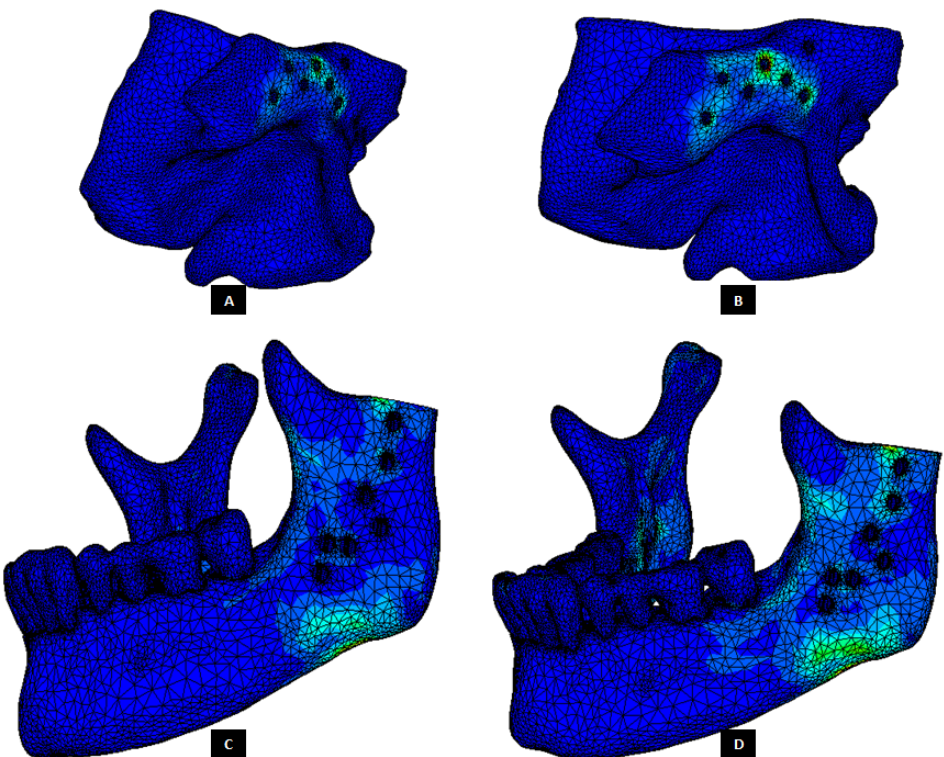
Figure 29. Stress distribution in the host bone components during FE simulations of the total TMJ replacement with custom designed simple TMJ prostheses. ( A , B ) Show von Mises stress in the fossa bone under normal and worst-case/over–load configurations, respectively. ( C , D ) Show von Mises stress in the mandibular bone under normal and worst-case/over–load configurations, respectively.